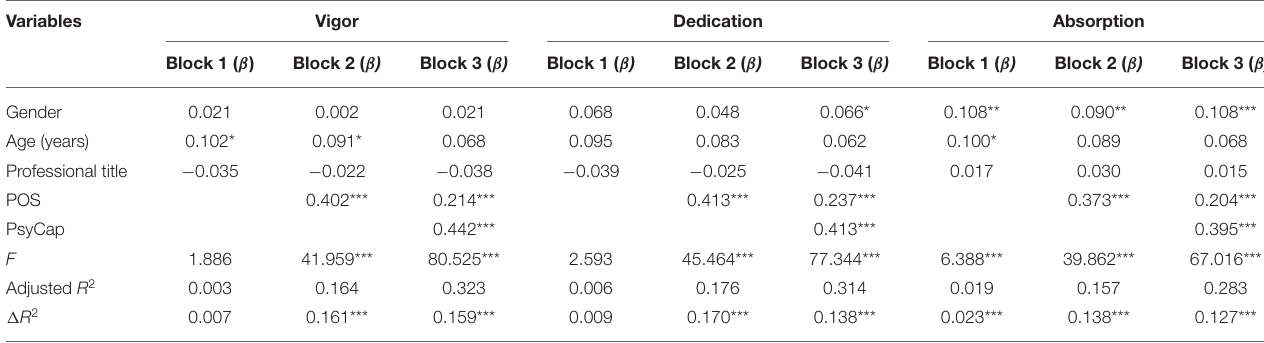
TABLE 3 | Associations of POS and PsyCap with vigor, dedication, and absorption.